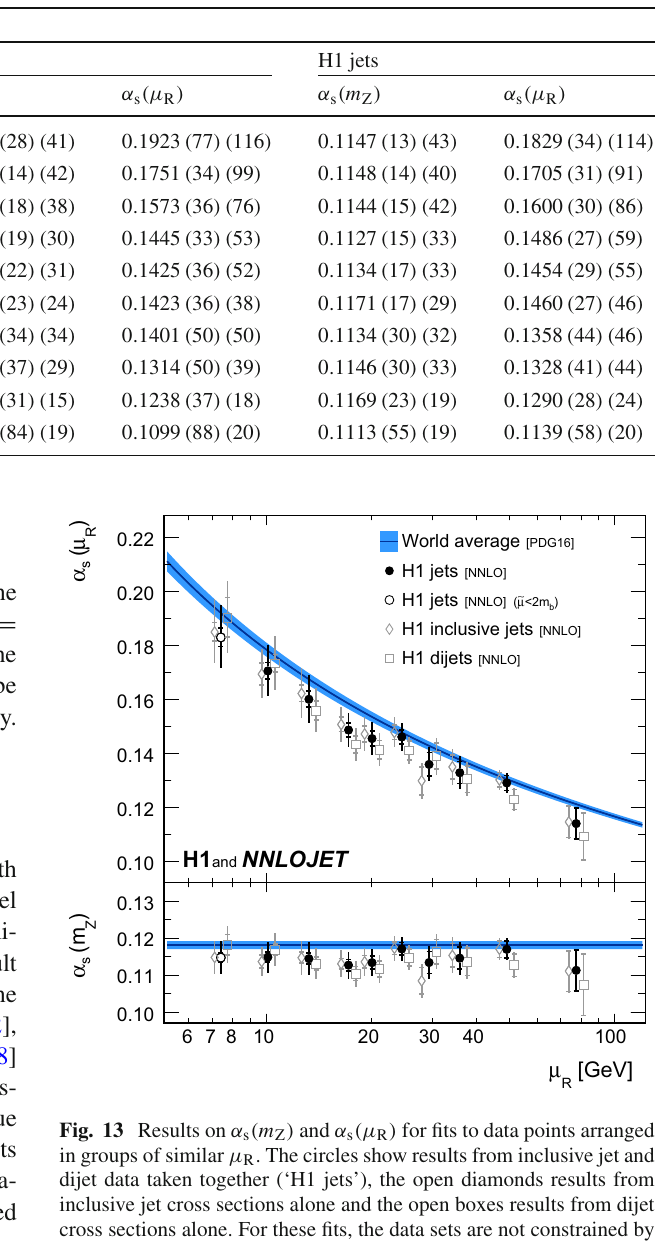
are somewhat larger than the uncertainties of NNPDF3.1. For